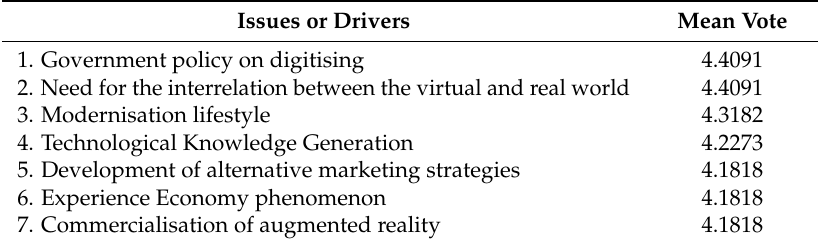
Table 2. Top issues or drivers for AR marketing in Malaysia.